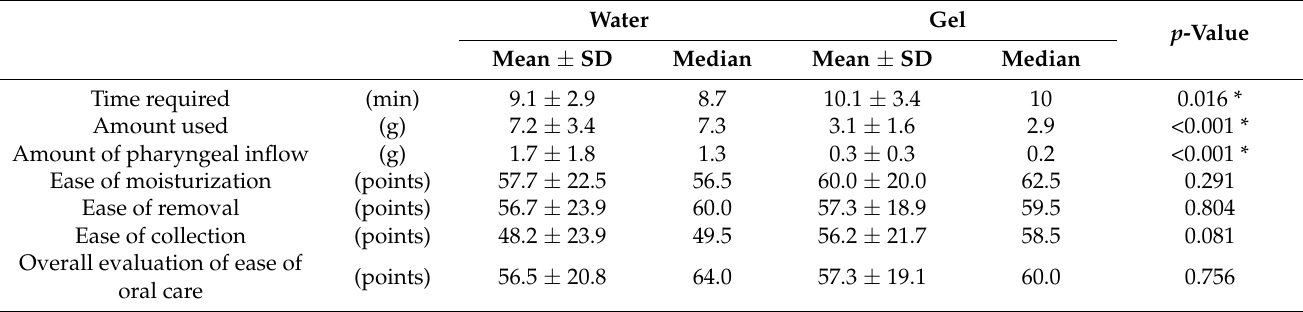
Table 3. Comparison of oral care using water and gel among students ( n =